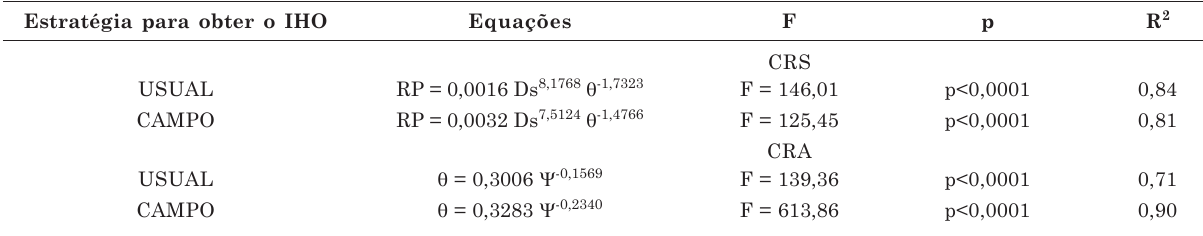
RP, em MPa;  , em m 3 m -3 ; Ds, em kg dm -3 ;  , em kPa.